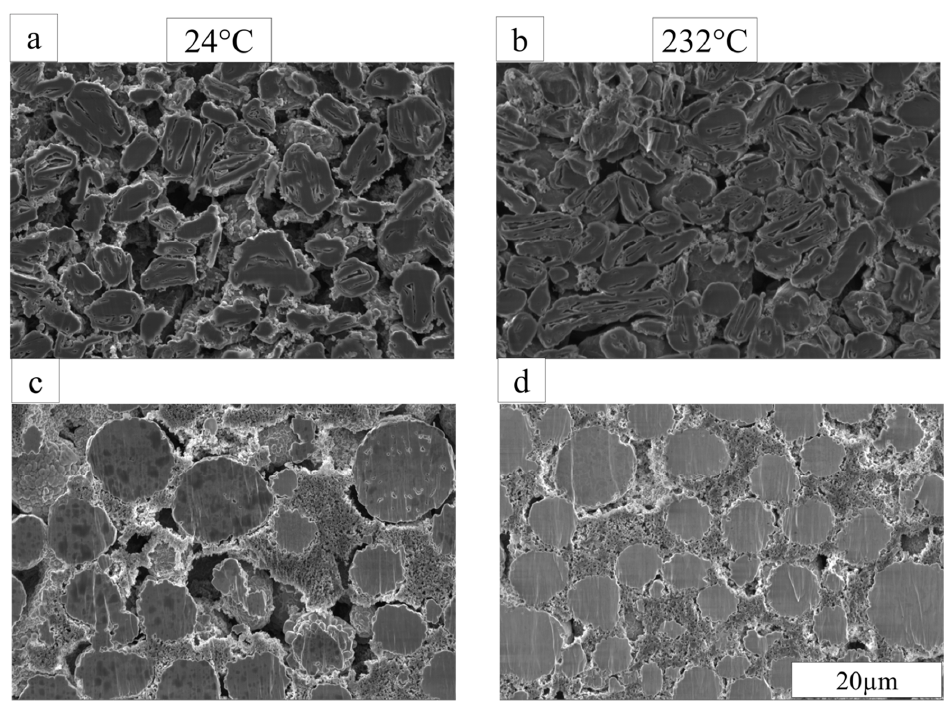
Figure 4. SEM images of the dried uncalendered graphite anode ( a , b ) and NMC cathode ( c , d ) at 24 °C and 232